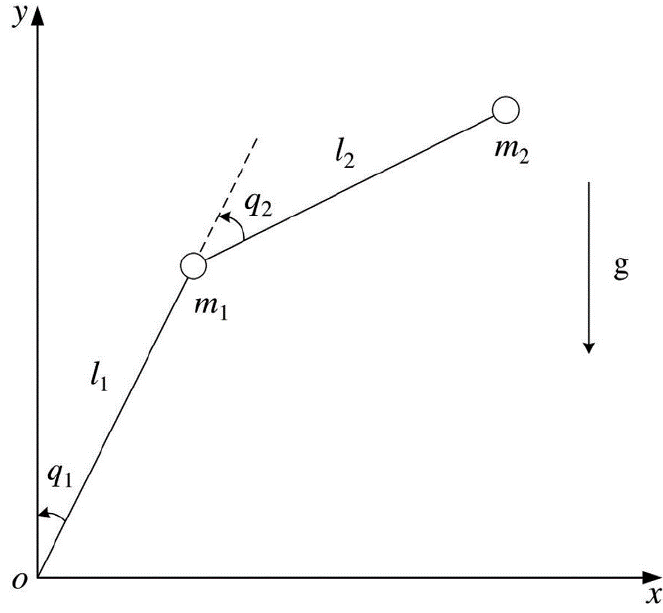
Figure 3. The robotic manipulator system.